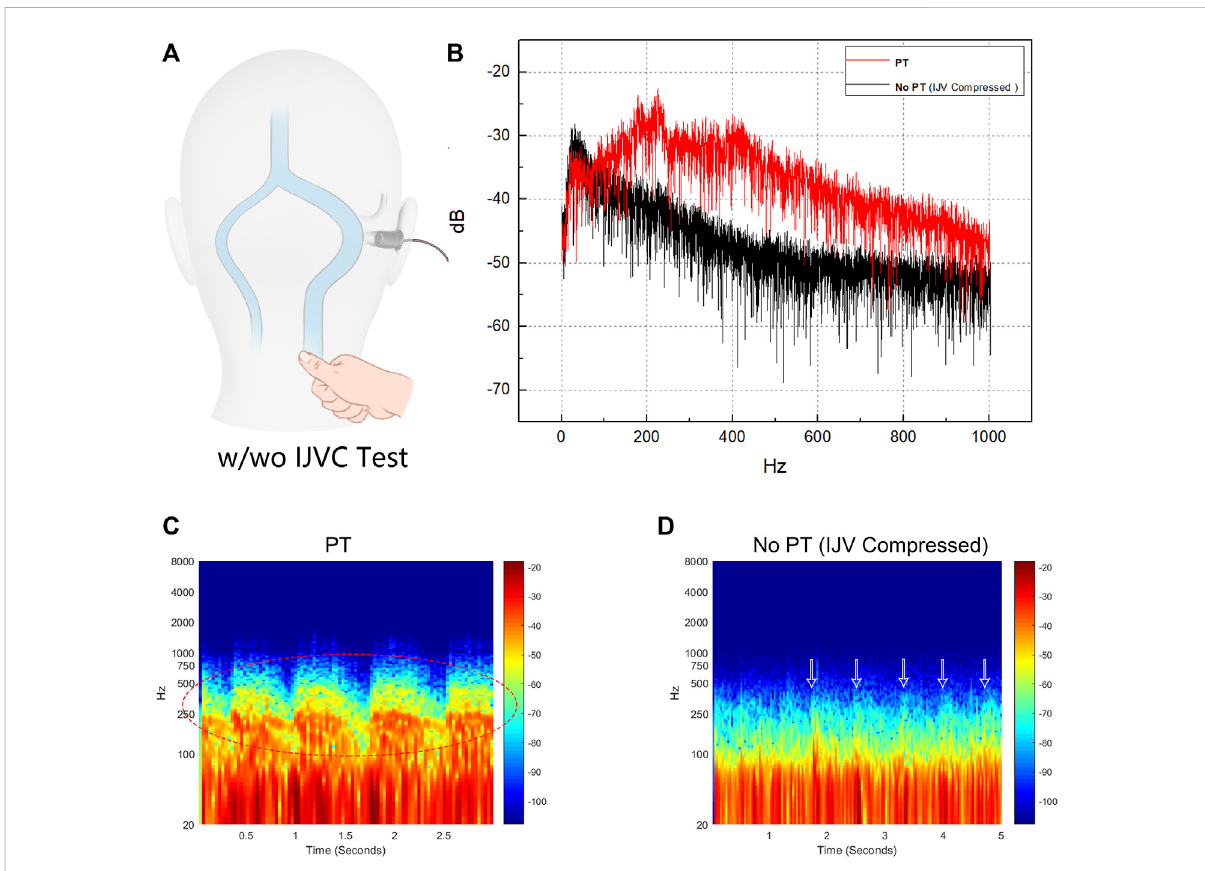
FIGURE 10 Results of trans-canal recording of produced pulse-synchronous somatosounds. PT indicates pulsatile tinnitus. (A) Schematic diagram of transcanalrecordingtechniqueperformedinjunctionwithipsilateralinternaljugularvein(IJV)compression. (B) Frequency-amplitudediagramofthe captured pulse-synchronous sound and without pulse-synchronous somatosound during which the ipsilateral IJV was compressed. (C) and (D) are the spectro-temporal results of the recorded pulse-synchronous somatosounds without IJV compression (PT) and with IJV compression (no PT). Notice that the main power of PT fl uctuates below 1,000 Hz (red octave dashed lines) and PT disappeared despite that the low pulse- synchronous noises were still detectable (white arrows).